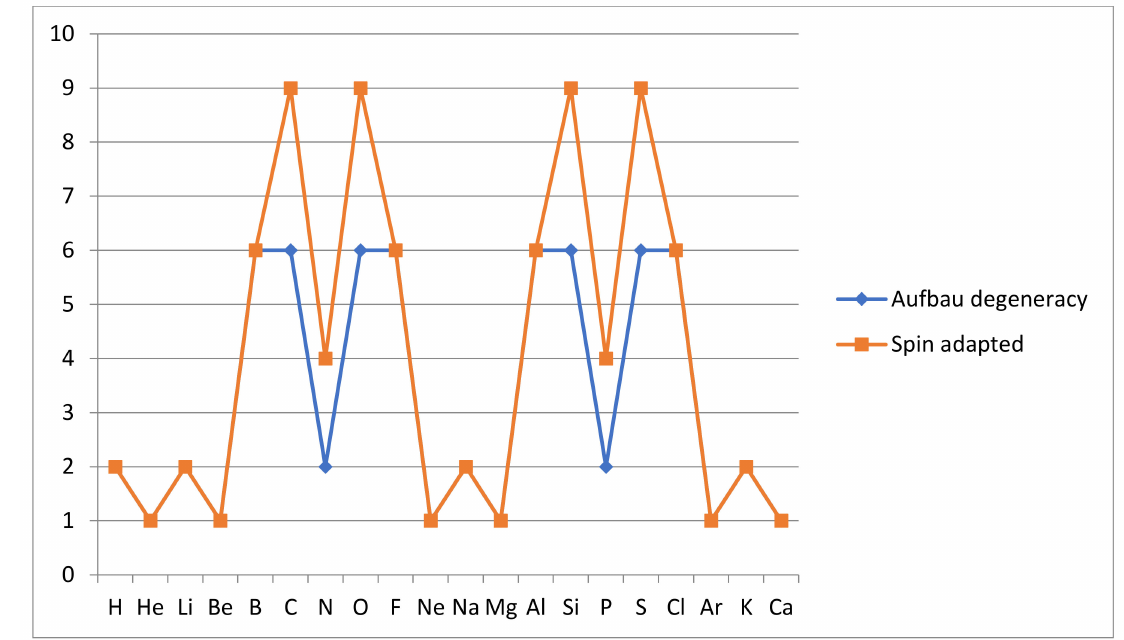
Figure 5. Aufbau degeneracies are compared with degeneracy of spin-adapted configuration combinations for the ground states of the first twenty atoms H, He, . . . Ca. Deviation is seen for C, N, O and Si, P, S. For other atoms Aufbau degeneracy is not changed by spin